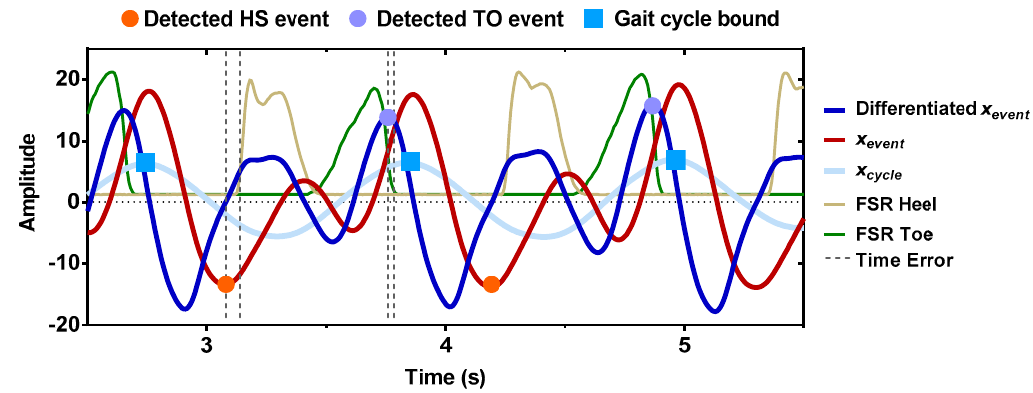
Figure 4. Temporal representation of HS and TO gait event detection based on the proposed general CWT algorithm. The first local minima of x event corresponded to the estimated HS event (orange circle). The second local maxima of the further di ff erentiated x event corresponded to the estimated TO event (purple circle). Each gait cycle bound was defined as the maximum points of x cycle . Vertical dashed lines indicated the time-errors between the estimated event and the reference event from the FSR method.